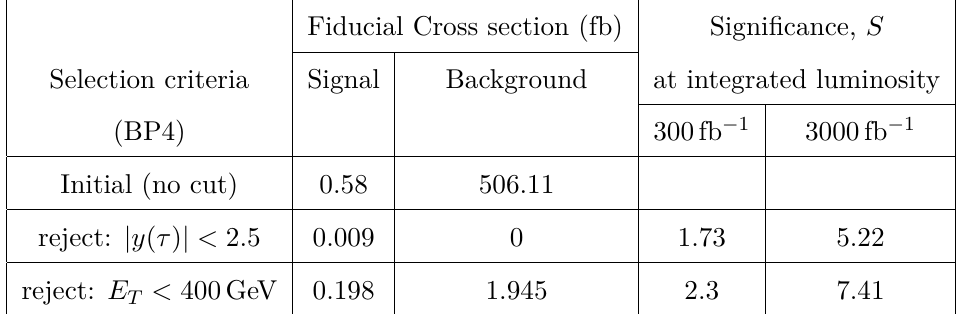
Table 14 . Fiducial cross section of the signal ( pp → H + ( pp → νντ + τ − ) corresponding to BP4 at 14 TeV LHC, with and without two selection criteria considered, and the signal significance (eq. (4.1)) at the